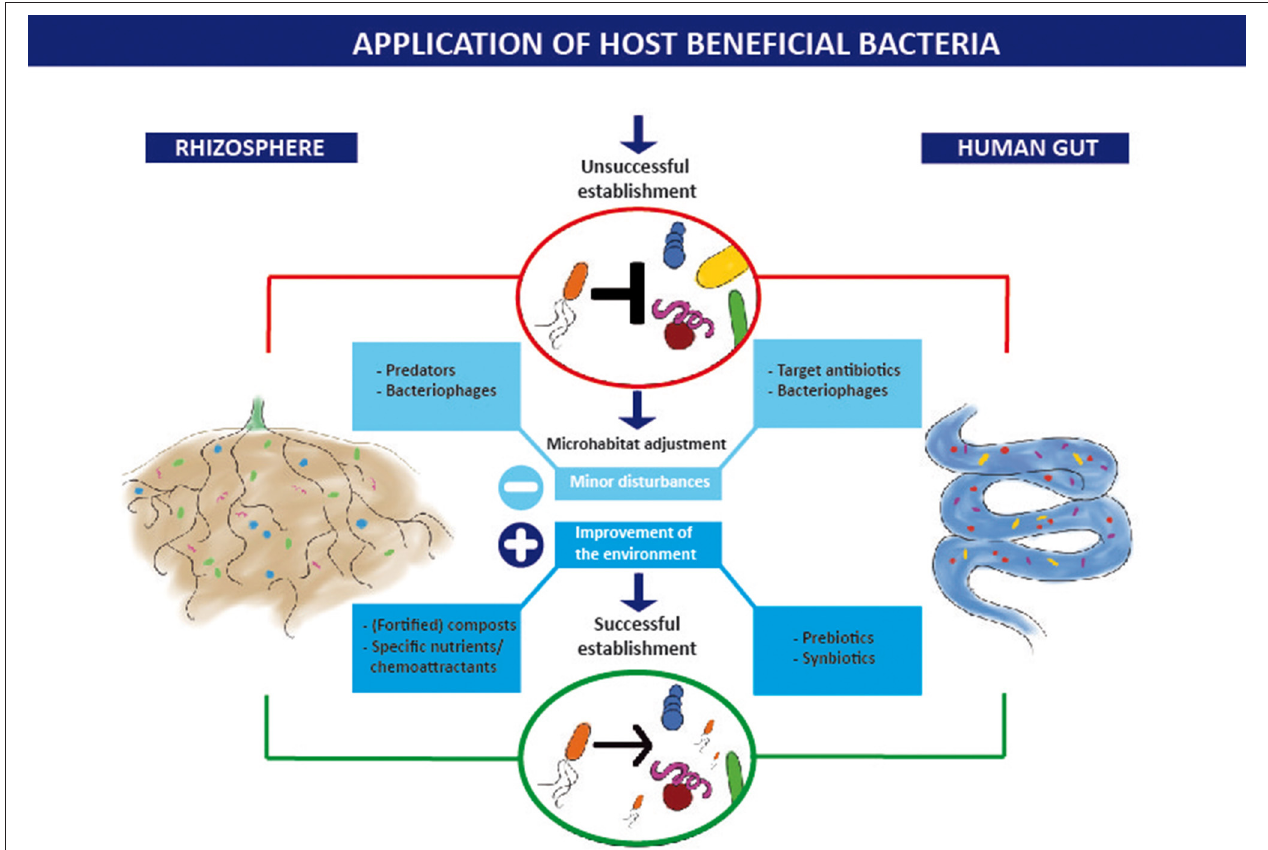
FIGURE 1 | Process of establishment of host beneficial bacteria (HBB) in the rhizosphere soil and the human gut. Application of HBB without additional measures frequently results in an unsuccessful establishment. To achieve a successful establishment of the HBB introduction of minor disturbances that empty host-associated niches in combination with improvements of the environment that create a new niche are suggested. Examples for the rhizosphere and the human gut.